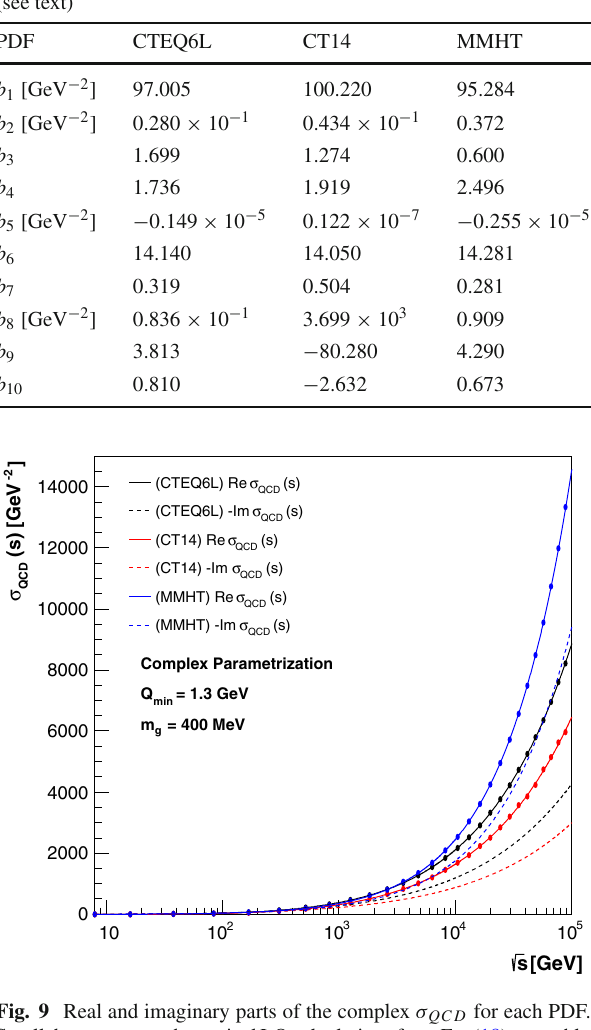
Table 9 Fit results of the Re σ QCD in Eqs. (1) and (2) to the actual data (see text)